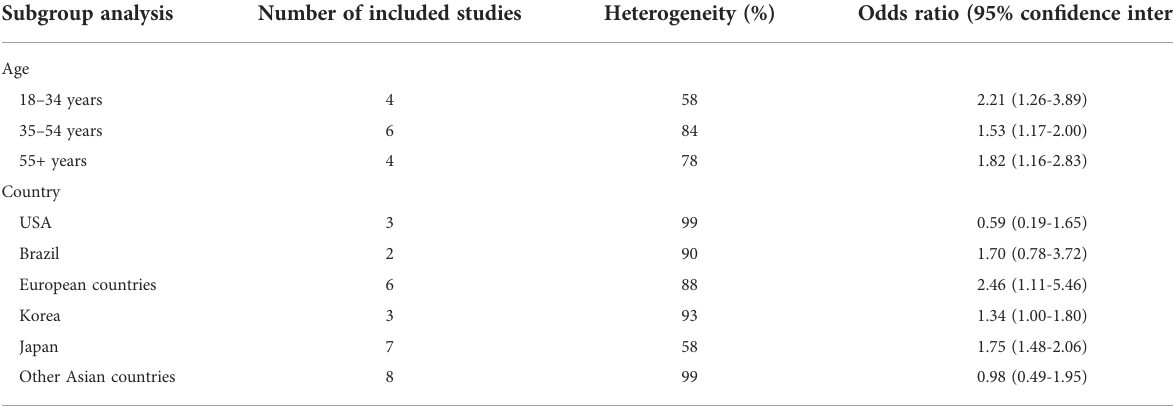
TABLE 2 Subgroup analysis strati fi ed by age and